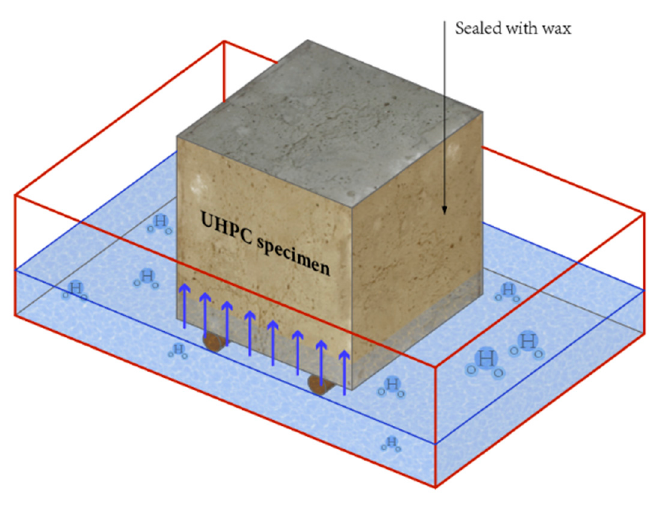
Figure 2. Diagram of the capillary water absorption test.